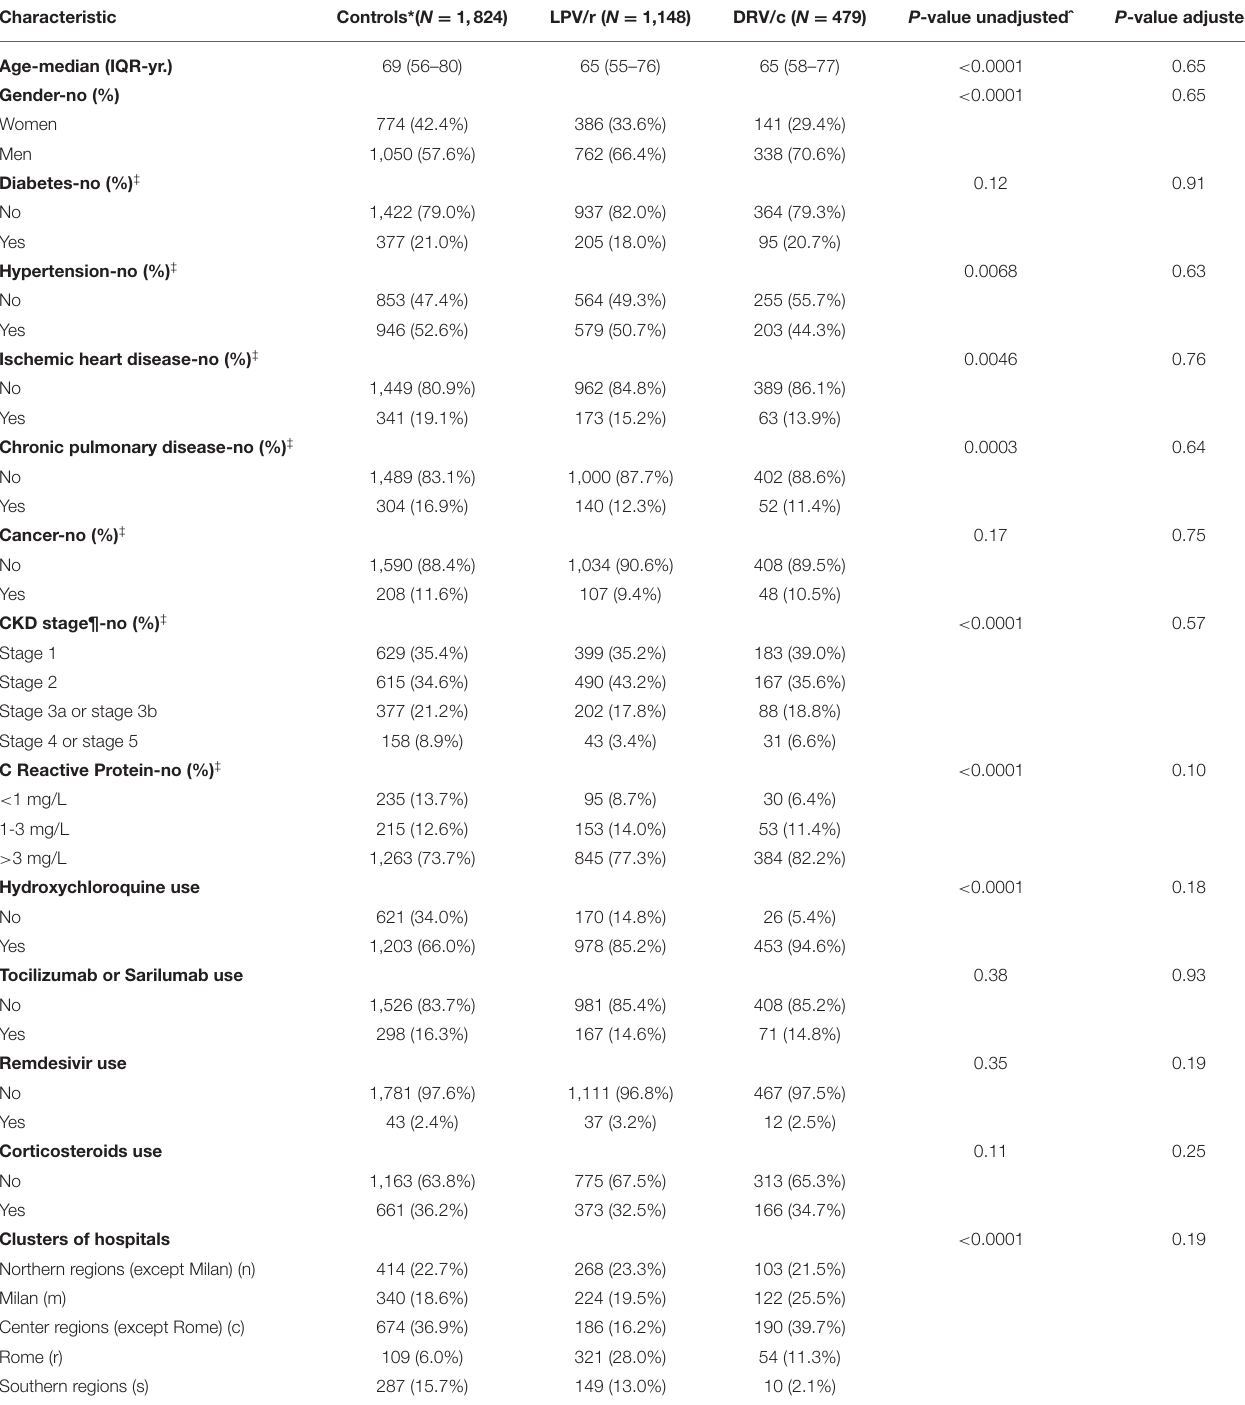
TABLE 1 | General characteristics of COVID-19 patients at baseline, according to lopinavir/ritonavir (LPV/r) or darunavir/cobicistat (DRV/c) use. Characteristic Controls*( N = 1,824) LPV/r ( N = 1,148) DRV/c ( N = 479) P -value unadjustedˆ P -value adjusted # Age-median